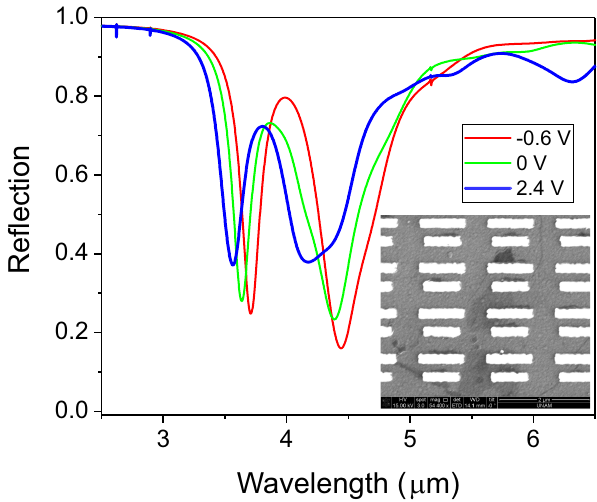
Figure 5. Reflection results of the two rectangular antenna design. The SEM image is presented in the